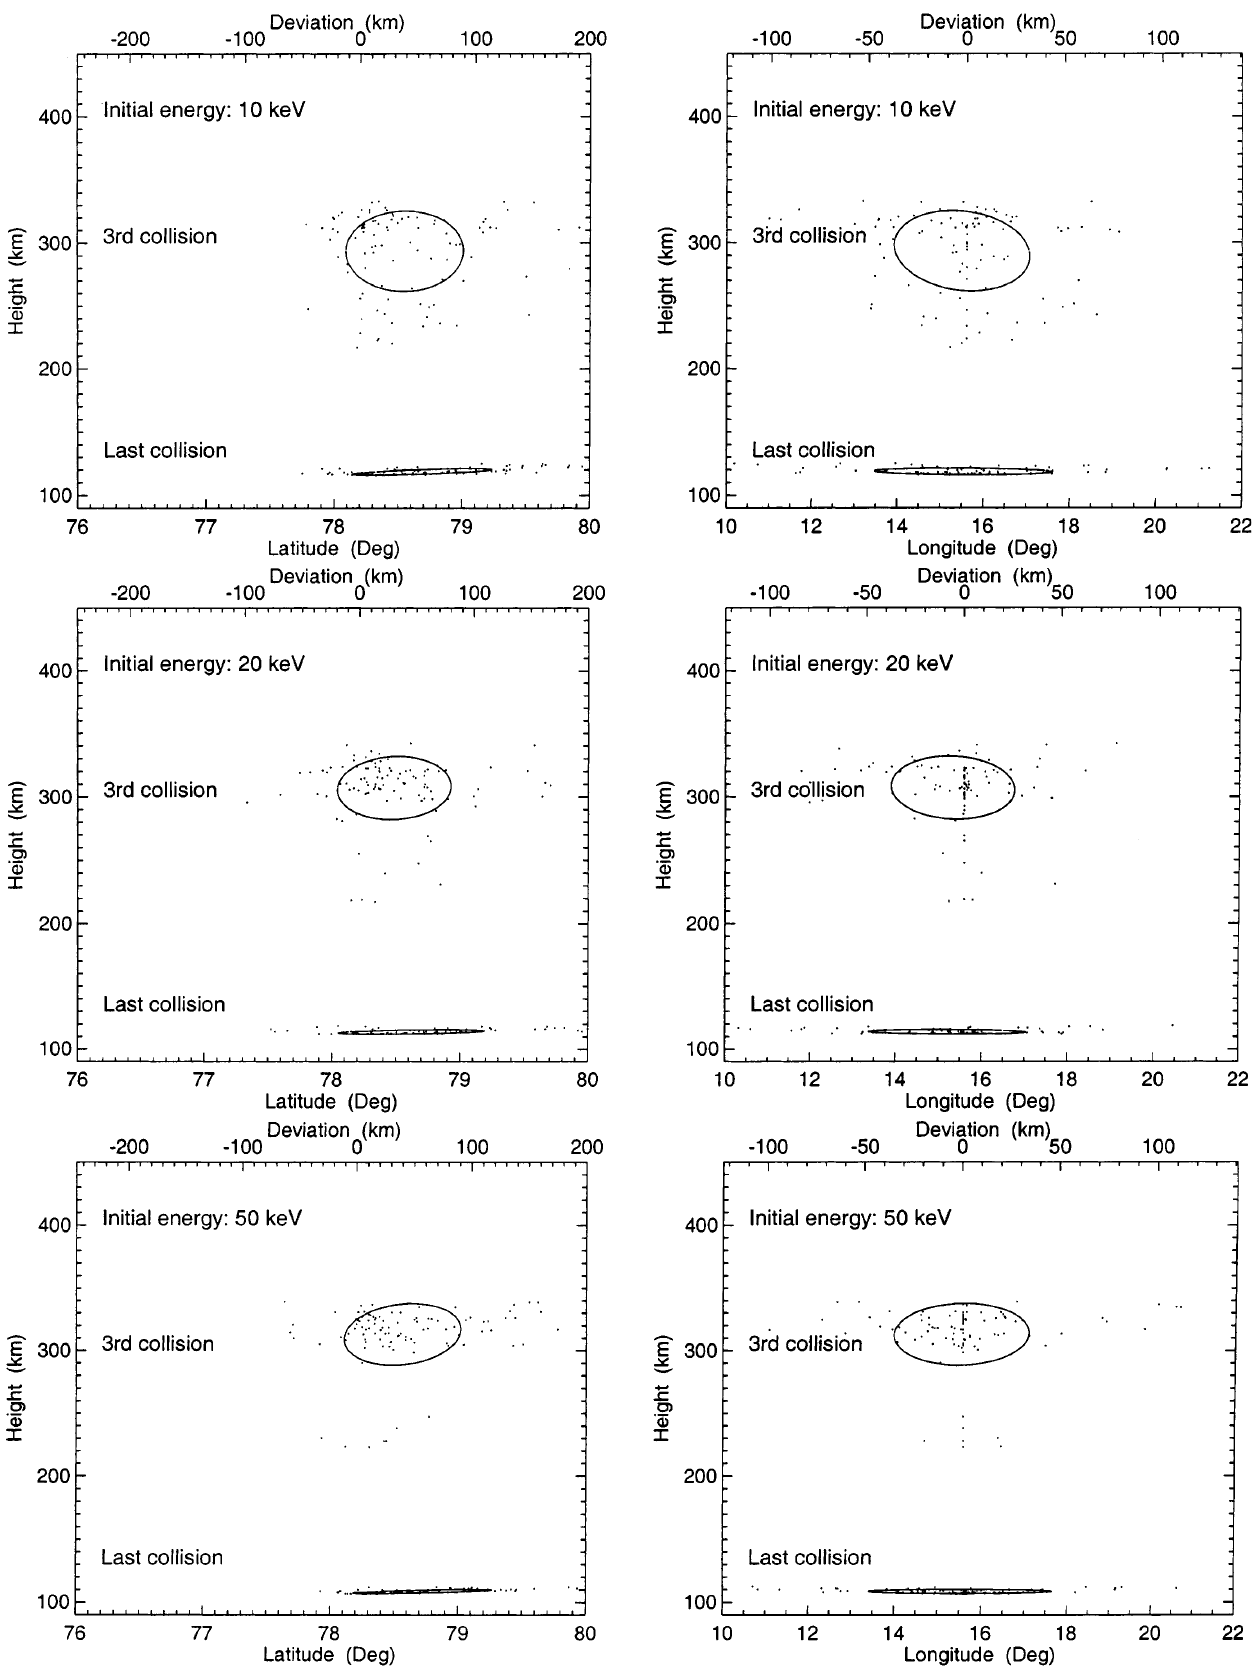
Fig. 2. Latitudinal and longitudinal dispersion at third and last collision, for initial energies of 10, 20 and 50